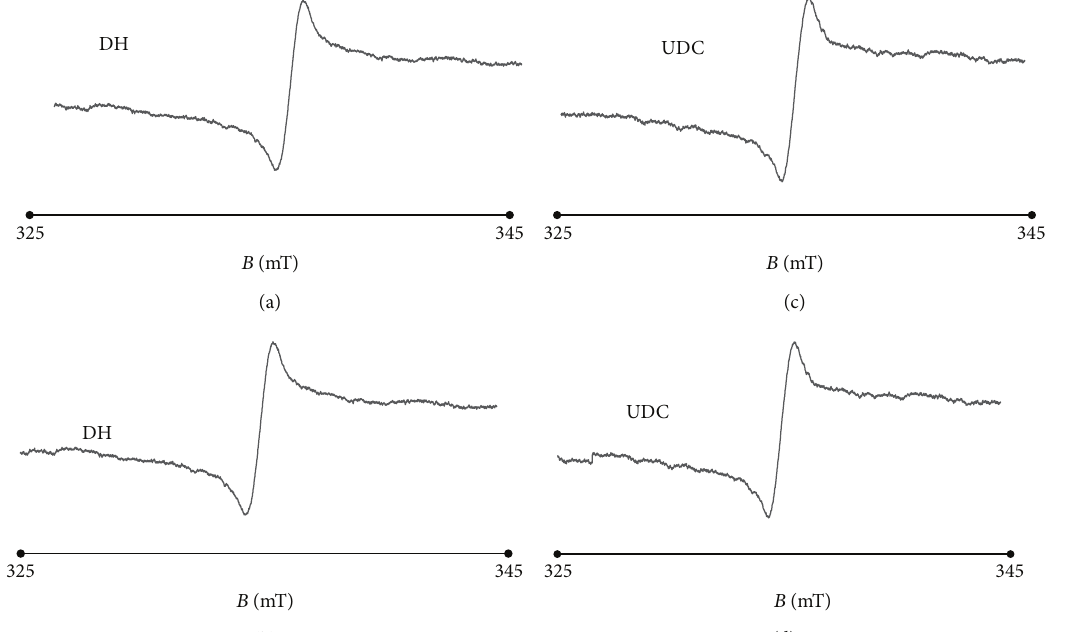
are listed in Table 1 increase slowly with the increase of the time of sterilization of investigated compounds. The concen- tration of free radicals (𝑁) in the UV irradiated dehydro- cholic acid (during 30 and 60 minutes) were about 169.10 × 10 17 spin / g and 178.10 × 10 17 spin / g, respectively (Table 1).